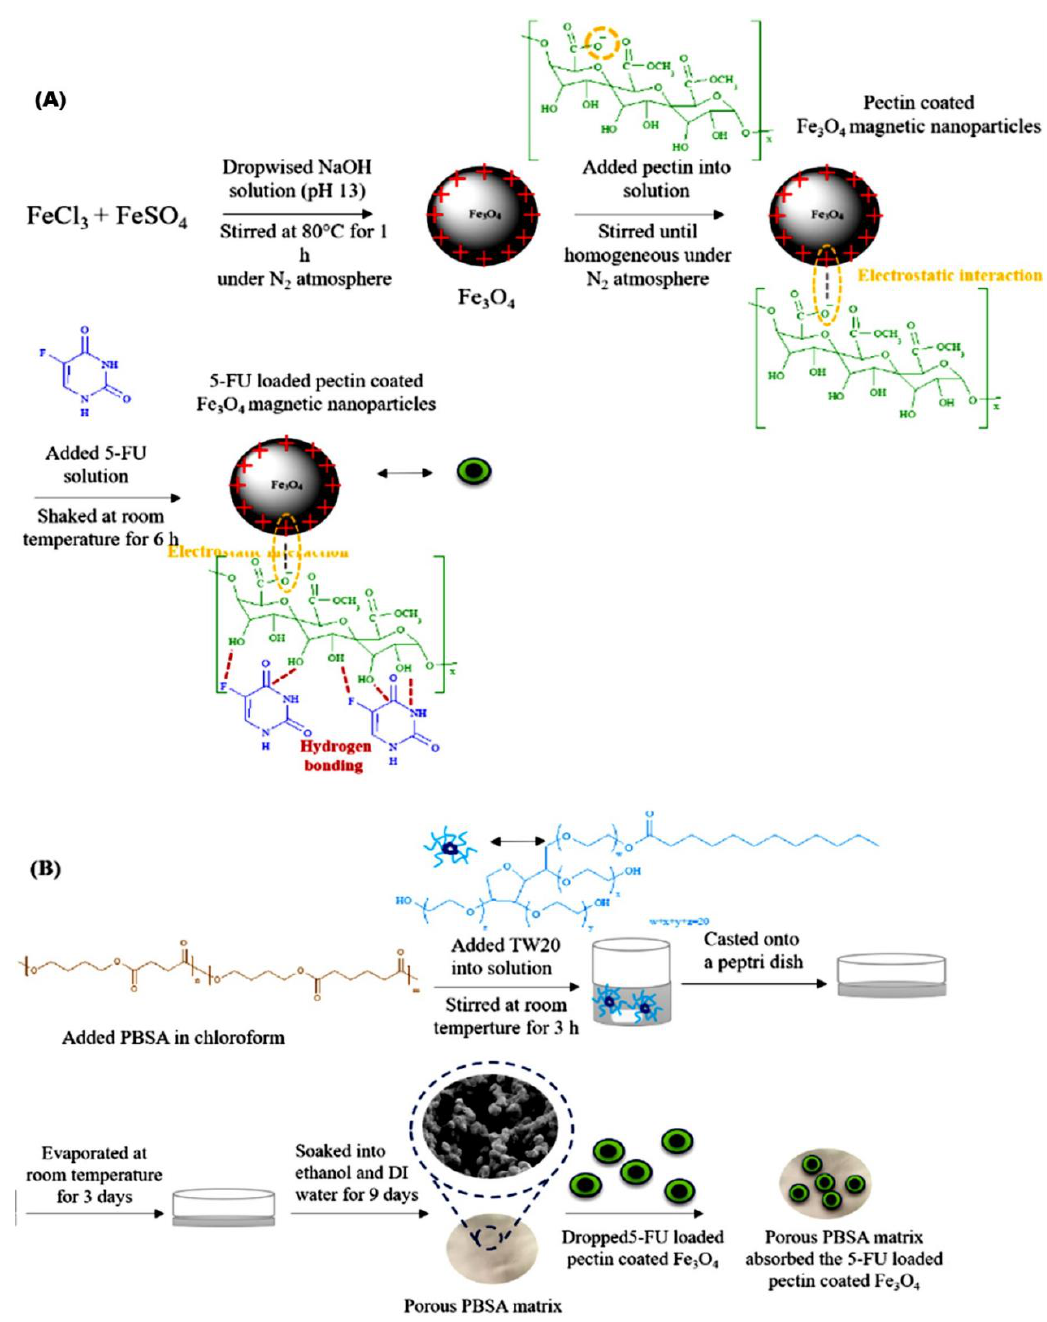
Figure 12. Illustration of ( A ) 5-fluorouracil-loaded pectin-coated Fe 3 O 4 MNPs; ( B ) porous poly(butylene succinate co adipate). Adapted from Viratchaiboott et al. [96].